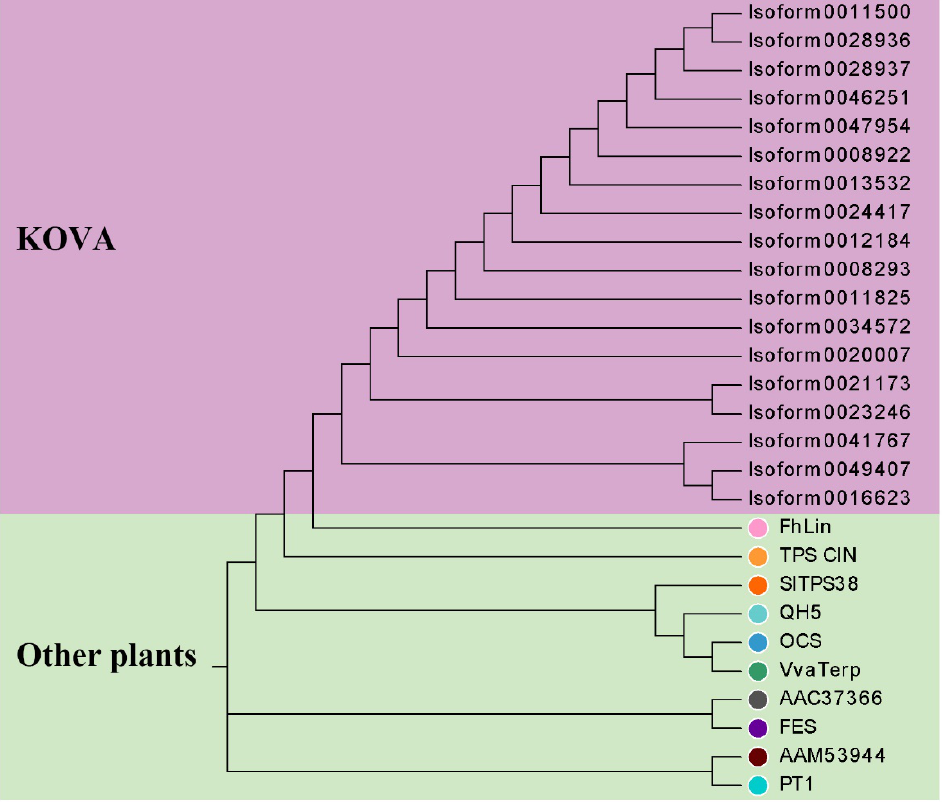
Figure 6. Phylogenetic relationships between RcMTPSs and MTPSs from other plants. All amino acid sequences without repeats from RcMTPs from KOVA and MTPs from other plants were used to establish a phylogenetic tree based on the neighbor-joining method. These data were employed to analyze the relationship between the MTPs. Protein abbreviations are as follows: FhLin, Freesia hybrid linalool synthase; TPS-CIN, Arabidopsis thaliana terpene synthase-like sequence-1,8-cineole; SlTPS38, Solanum lycopersicum terpene synthase 38; QH5, (3R)-linalool synthase; OCS, trans -beta-Ocimene synthase; VvaTerp, Vitis vinifera (-)-alpha-terpineol synthase; AAC37366, 4S-limonene synthase; FES, fenchol synthase; AAM53944, (R)-limonene synthase; PT1, Pinus taeda (-)-alpha-pinene